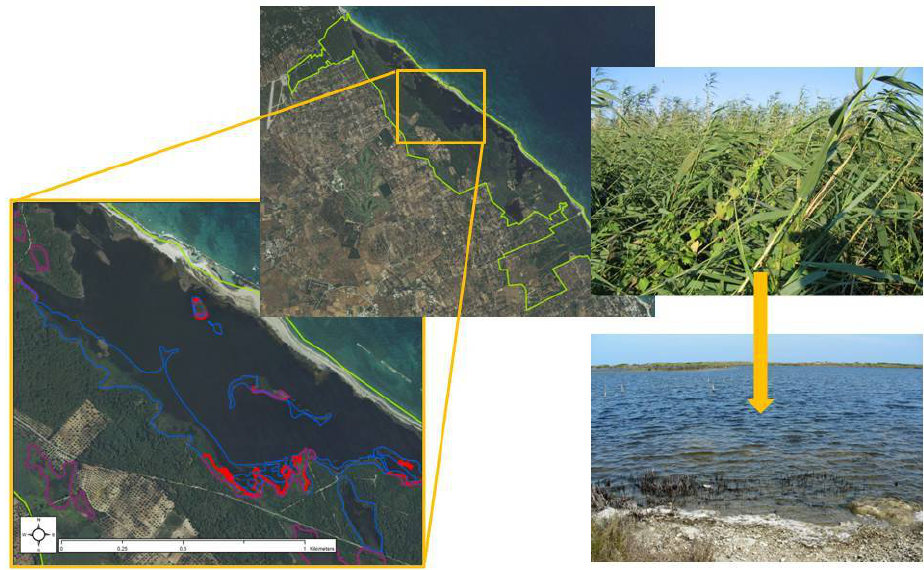
Figure 6. A severe reduction of reedbeds was observed in the CE site. This process was localized mostly in the central part of the protected area; in blue, the reedbeds distribution in 2007 and, in red, in 2014.